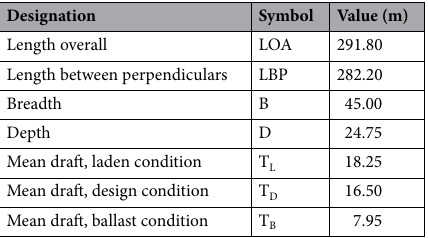
Table 1. Principal particulars of the 176 k DWT bulk carrier.